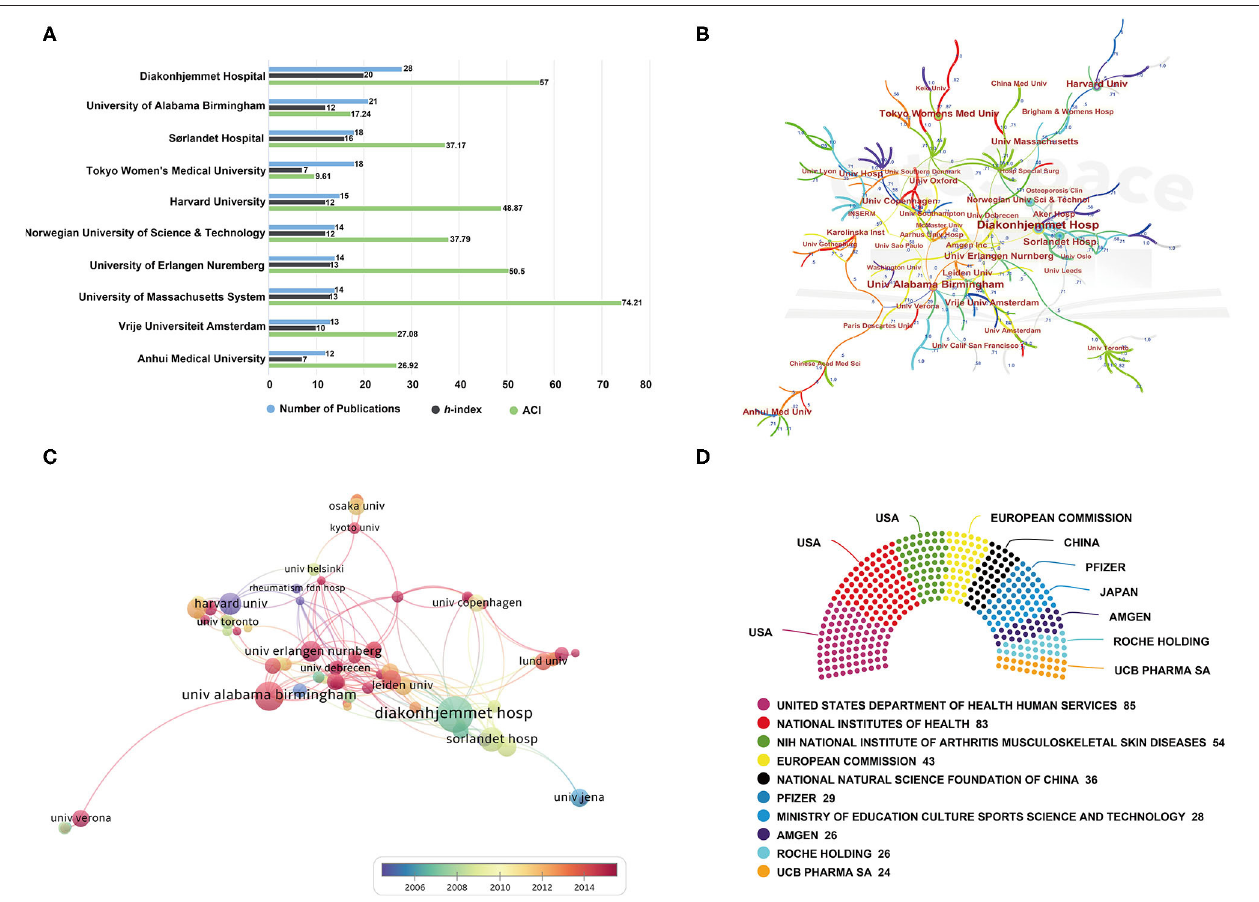
FIGURE 3 | (A) The publication counts, h -index, and ACI of the top 10 most prolific institutions. (B) Visualization map of institution cooperation generated by CiteSpace software. (C) Overlay visualization map of institution co-authorship analysis generated by VOSviewer software. (D) The top 10 most active funding agencies in ORA